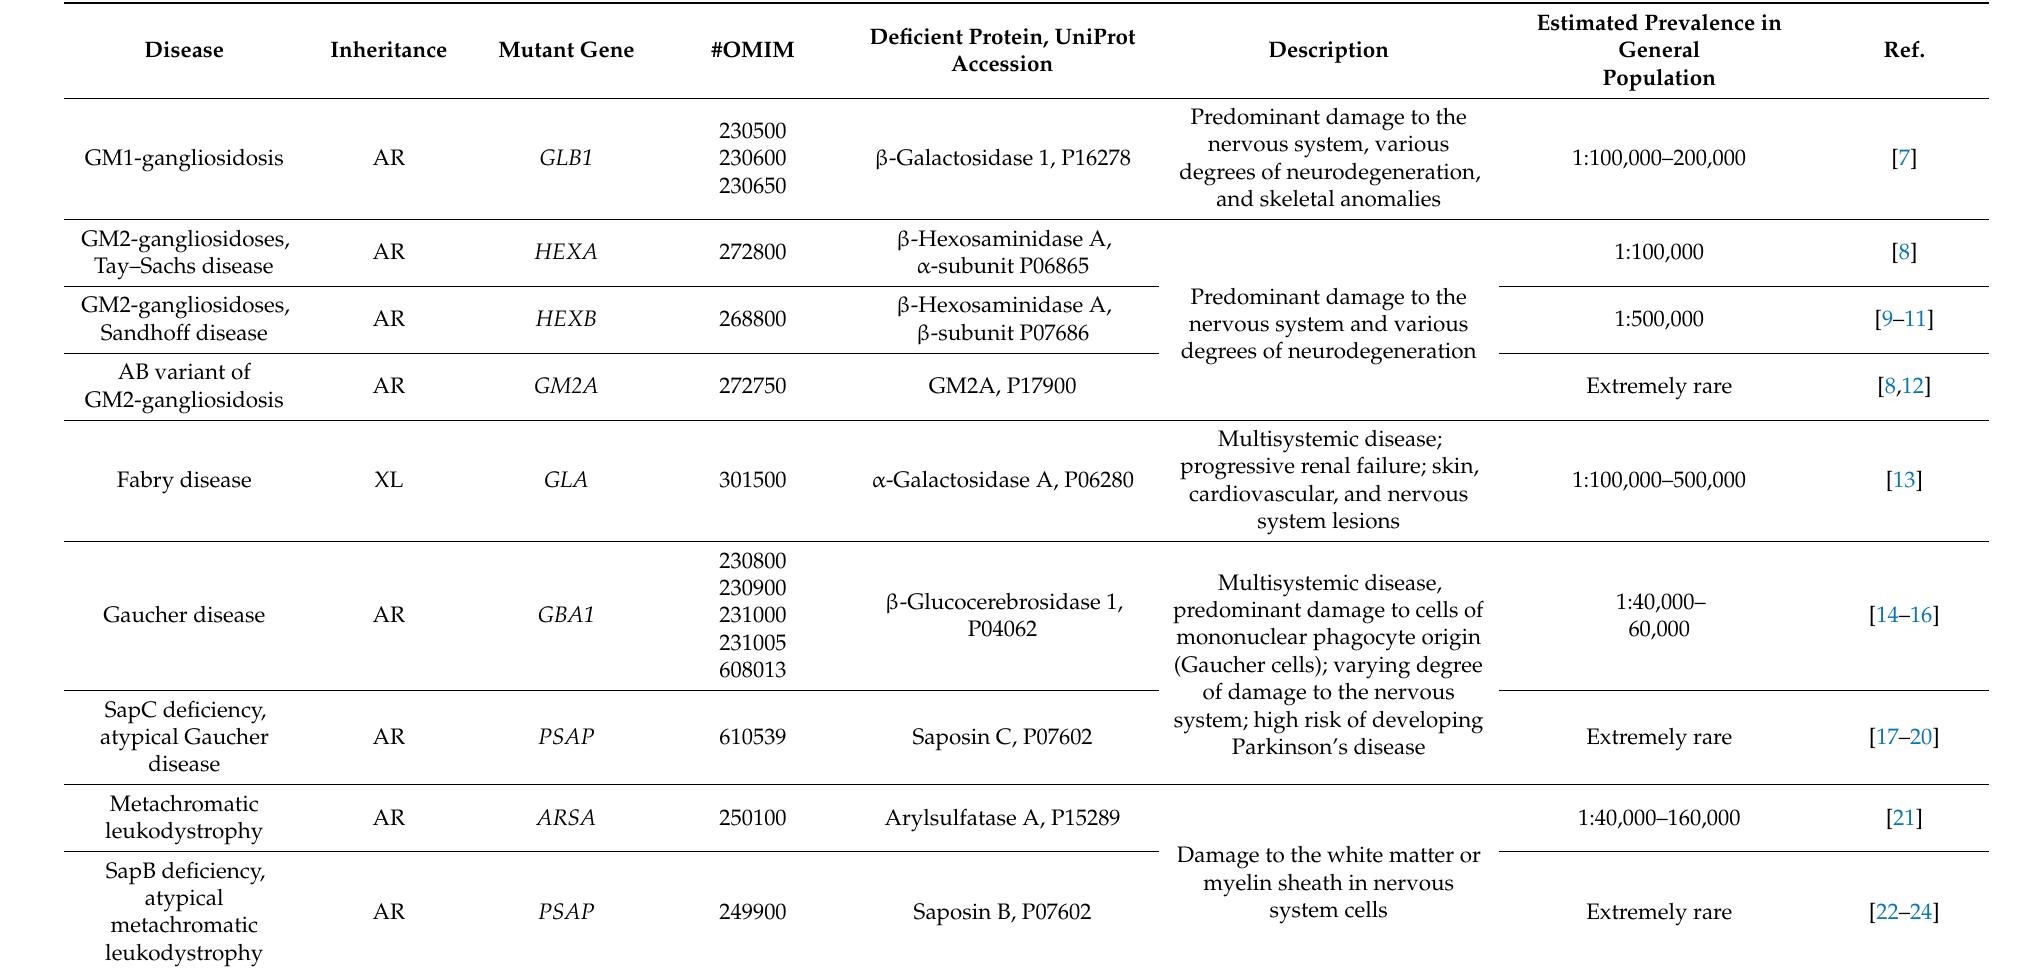
Table 1. Description of